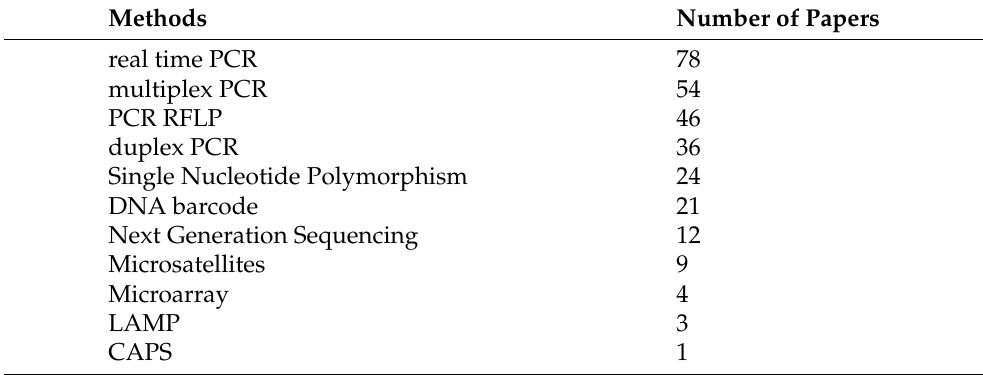
Table 2. Papers classified per